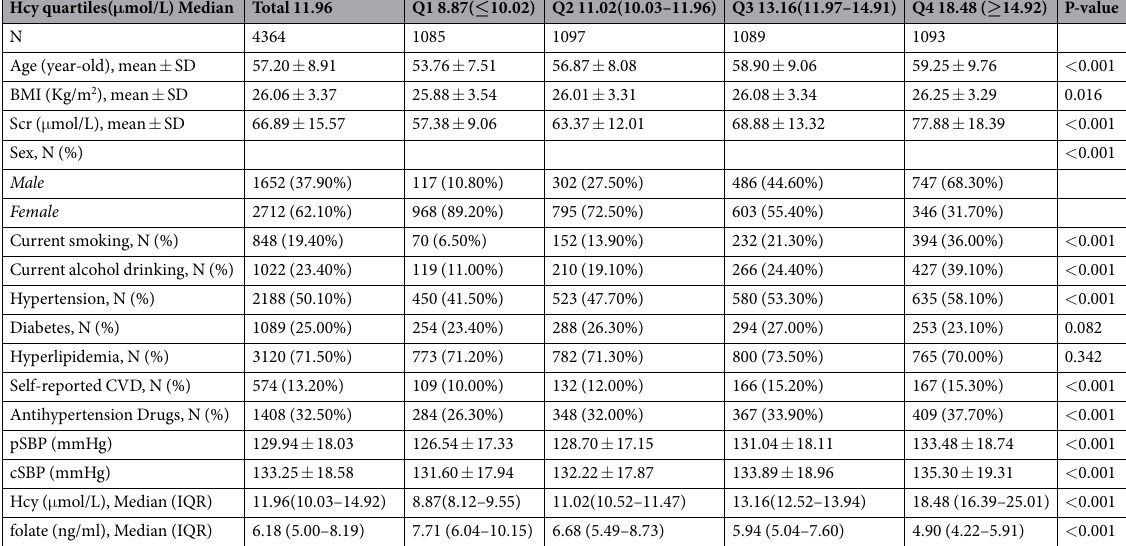
Table 1. Baseline Characteristics stratified by Hcy quartiles. Abbreviations: Hcy, homocysteine; Scr, serum creatinine; BMI, body mass index; cSBP, central systolic blood pressure; pSBP, peripheral systolic blood pressure; CVD, cardiovascular